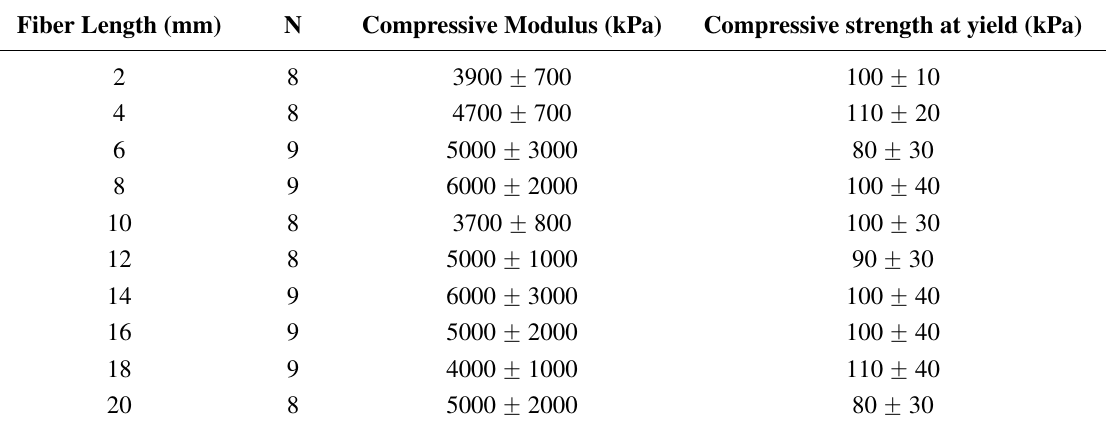
Compressive moduli and yield strengths vs. fiber length for the hemp compression